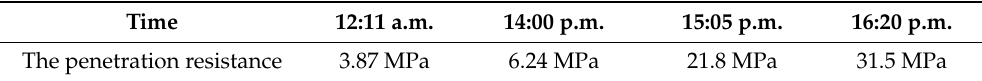
Table 3. Tested values of the shear strength of the super-early-age concrete (kPa). Time